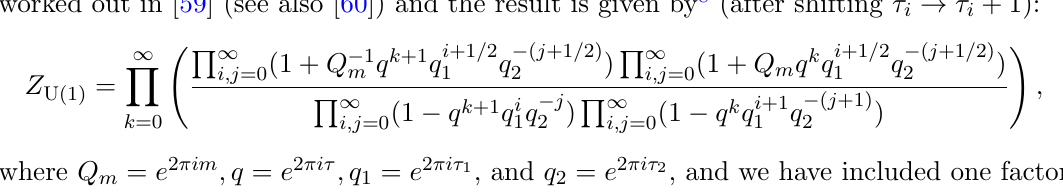
JHEP10(2018)051